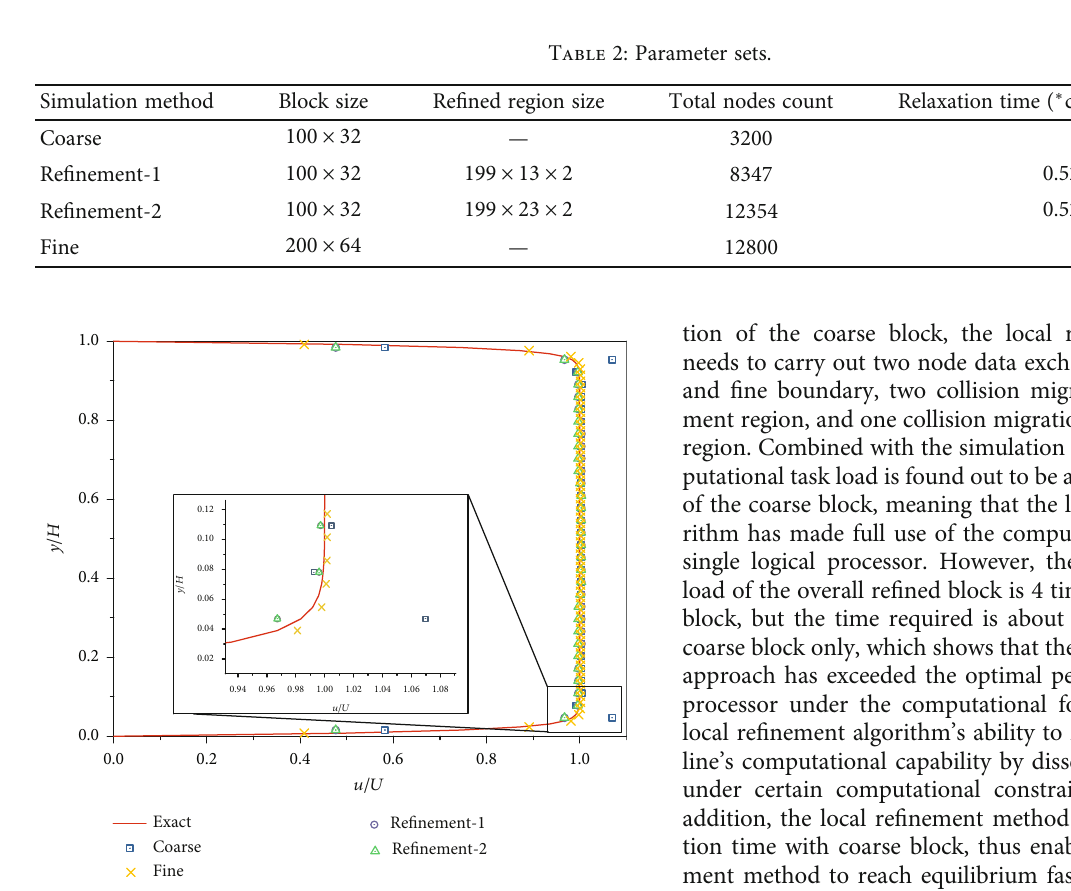
Figure 7: Poiseuille fl ow solution with di ff erent grid settings. Table 3: Parameter